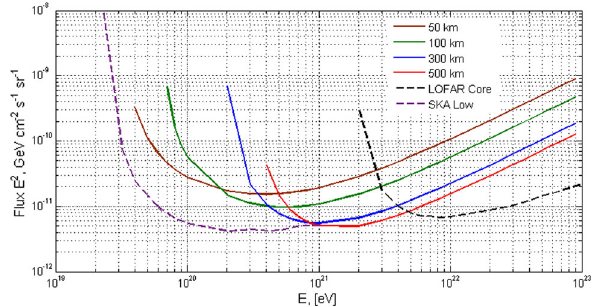
Fig. 4 UHE cosmic ray flux of a lunar orbital ULW radio antenna at different altitudes of 50, 100, 300, and 500km for one-year observation. The results are compared with the flux limits of both SKA Low for a 1000-h observation between 100 and 350 MHz (reproduced from Bray et al. [9]) and LOFAR for a 90-day observation between 125 and 175 MHz (reproduced from Singh et al. [47])